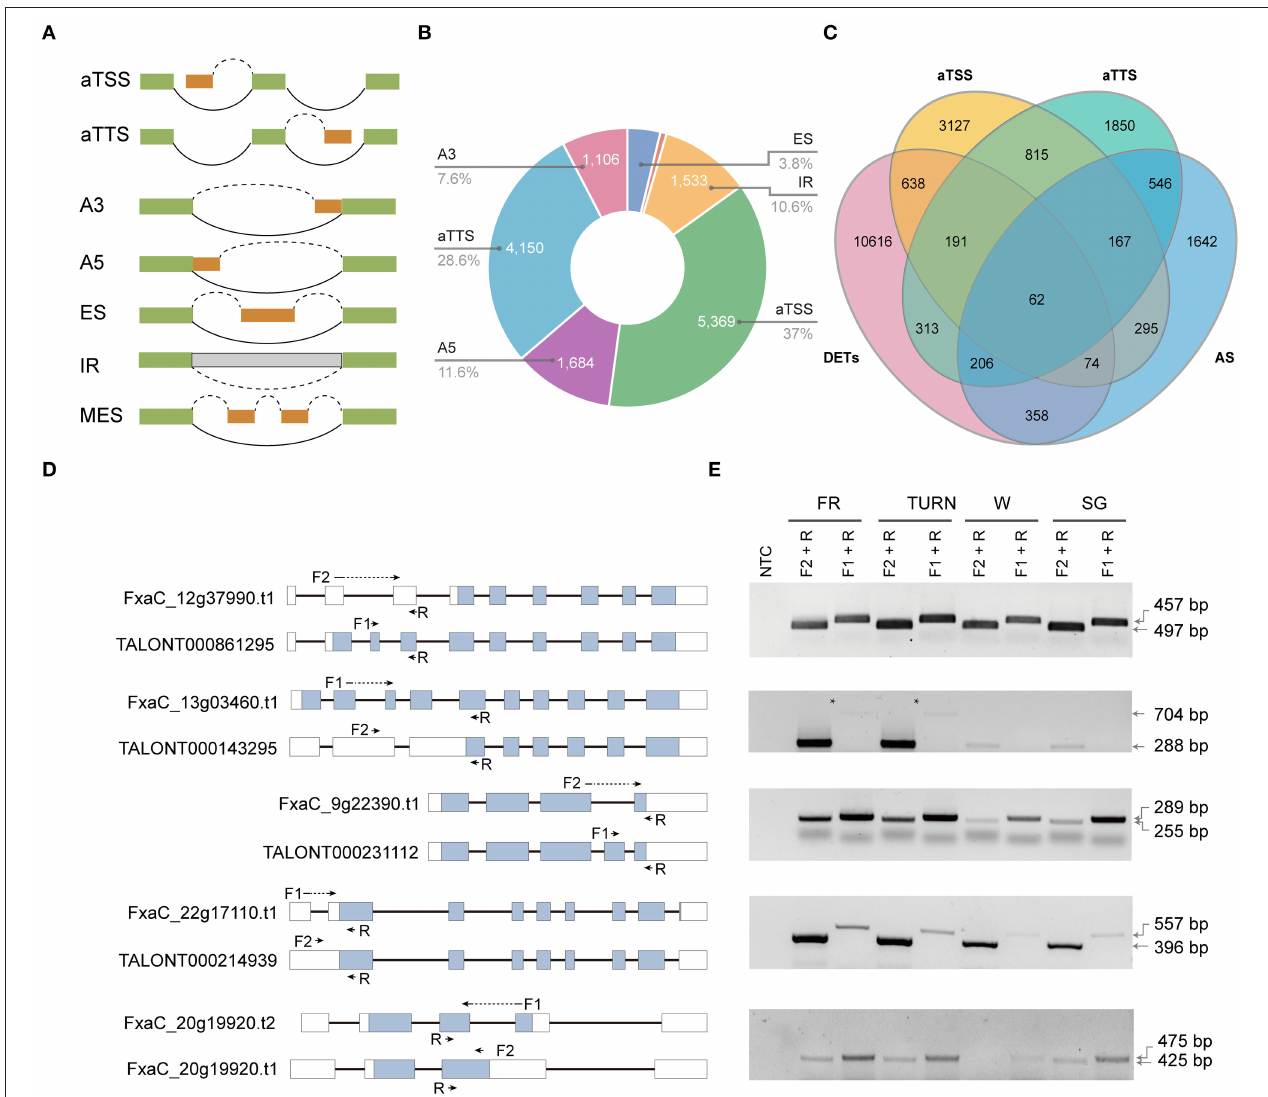
FIGURE 3 | Alternative isoform production events (aTSS, aTTS, and AS) investigated and their relative contribution to the transcriptome complexity and transcript expression. (A) The isoform production patterns defined. (B) The number and proportion of transcripts derived from the seven modes. (C) Venn diagram showing the overlapping transcripts derived from aTSS, aTTS, or AS with those being differentially expressed. (D) The gene model of the selected genes each with two selected isoforms. The location of the primers was labeled using arrows. Those primers spanning an intron were marked using dotted lines. (E) RT-PCR validation of the isoforms with specific primer combinations in the four successive developmental